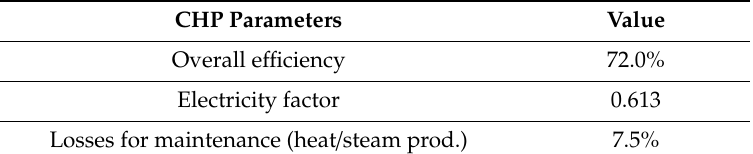
Table 4. Characteristic of the CHP unit used in this process